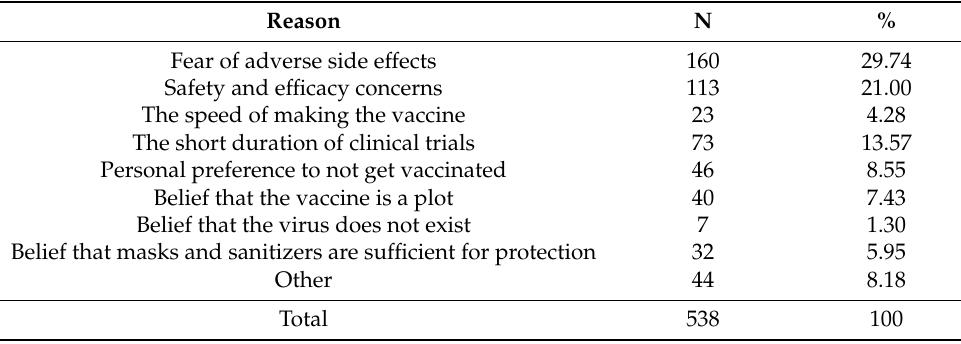
Table 3. Reasons for not accepting the COVID-19